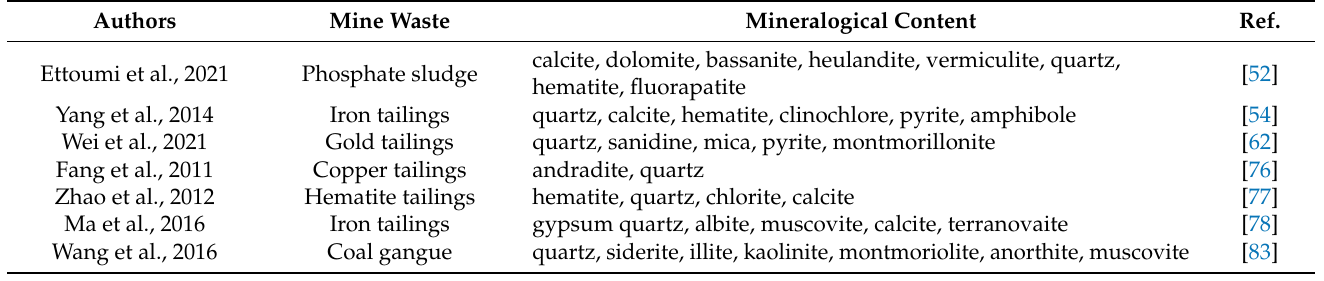
Table 1. Mineralogical composition of selected mining waste.